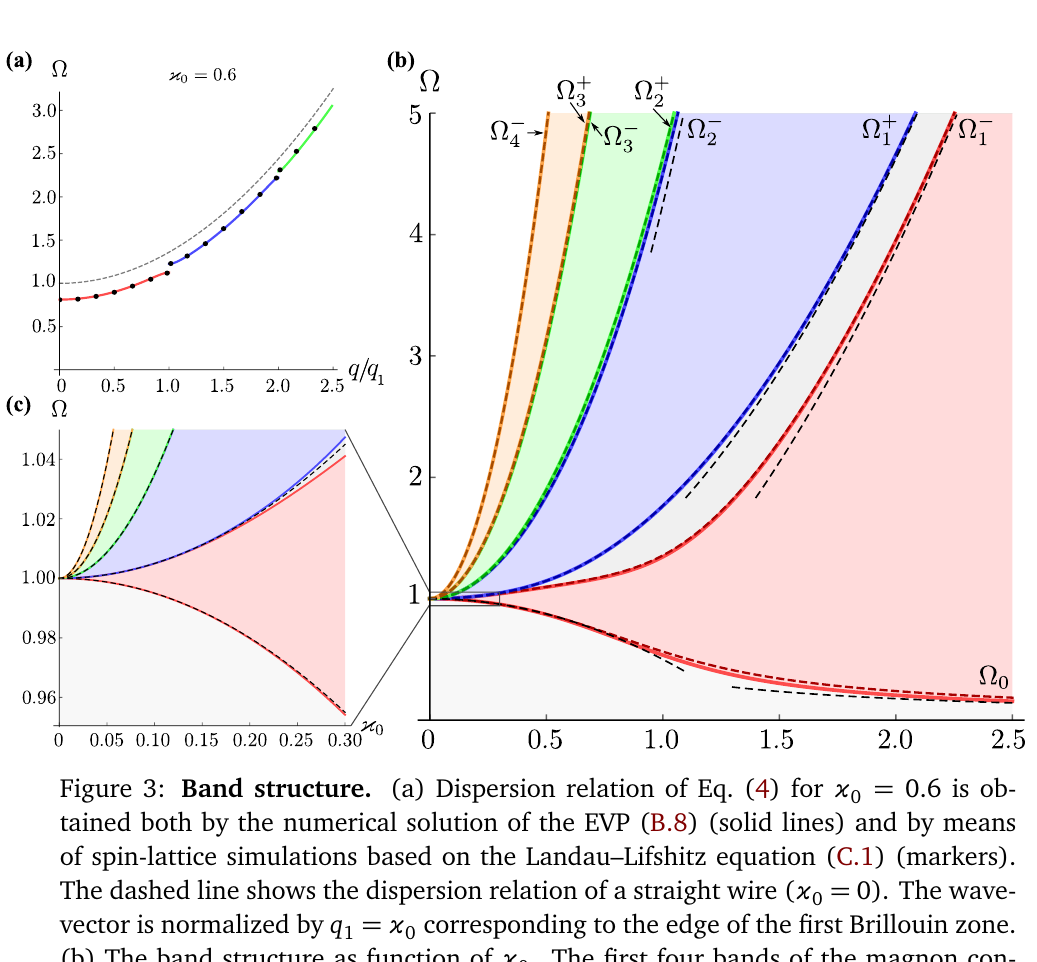
= 0.6 is ob- Figure 3: Band structure. (a) Dispersion relation of Eq. (4) for (cid:99) 0 tained both by the numerical solution of the EVP (B.8) (solid lines) and by means of spin-lattice simulations based on the Landau–Lifshitz equation (C.1) (markers). = 0). The wave- The dashed line shows the dispersion relation of a straight wire ( (cid:99) 0 = (cid:99) vector is normalized by q corresponding to the edge of the first Brillouin zone. 1 0 (b) The band structure as function of (cid:99) . The first four bands of the magnon con- 0 ductance are shown by different colours and gaps are shown by grey shading. Solid and dashed thick lines correspond to the exact numerical solution explained in Ap- pendix B.1 and to the approximations (8)-(9), respectively. The thin dashed lines correspond to the analytical asymptotes listed in Table 1. The inset (c) shows details of the band structure for small curvatures, the notations are the same as in